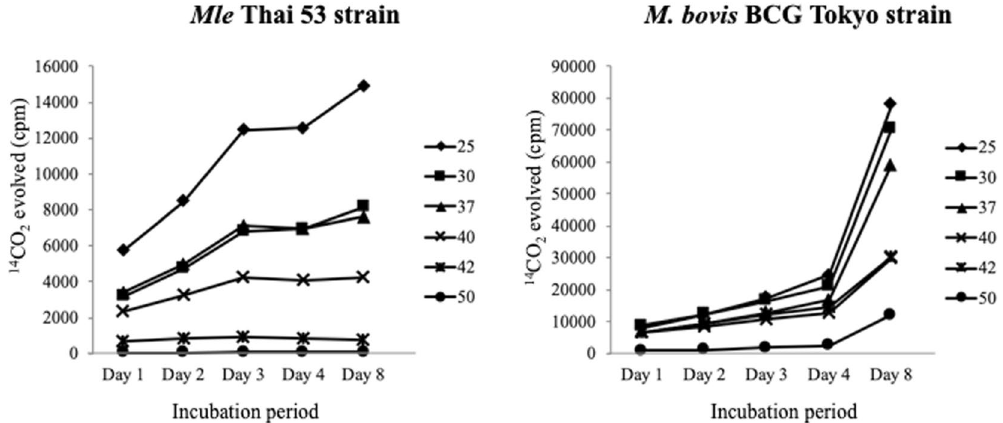
Figure 4. Thermosensitivity of Mle- and M. bovis BCG strains. Mle Thai-53 (left) and M. bovis BCG Tokyo (right) were pre-incubated for 1 h at 25 °C –50 °C, placed on ice for 1 h, and then grown in a BACTEC 12B medium at 30 °C and 37 °C, respectively. Viability was determined by radiorespirometry analysis, which evaluates the oxidation of 14 C-palmitic acid to 14 CO 2 . Total isotope release was analysed every day for 8 days; ◆, ■ , ▲ , × , * , and ● , strains pre-incubated at 25 °C, 30 °C, 37 °C, 40 °C, 42 °C, and 50 °C, respectively.